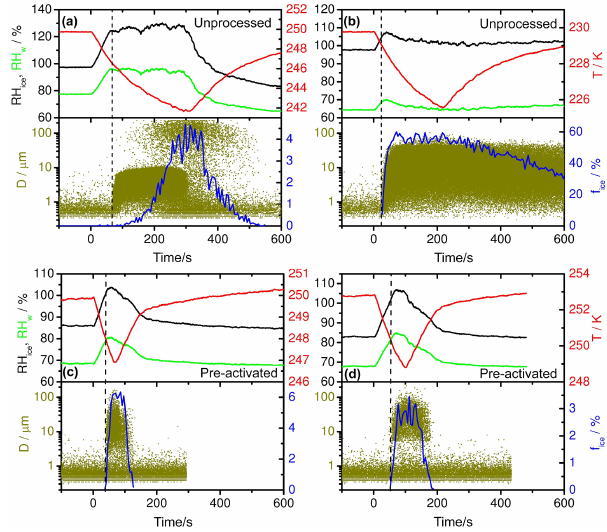
Figure A1. Comparison of the ice nucleation characteristics of pre- activated CBV400 and CBV100 particles during expansion cooling started at 250K (a, b) and 253K (c, d) . The data types are the same as shown in Fig. 3.